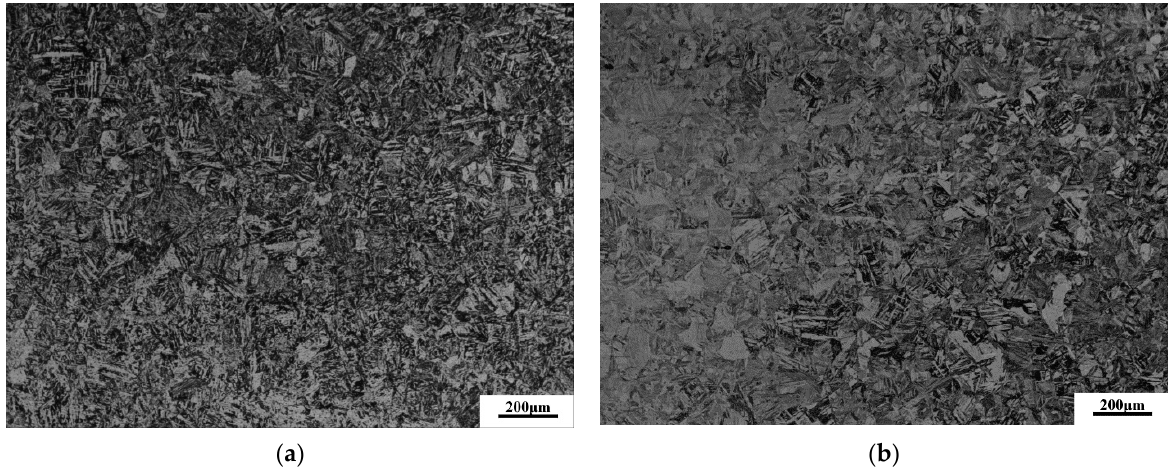
Figure 2. Microstructure of the KMN-I welded joint. ( a ) Welded seam; ( b ) fusion zone.